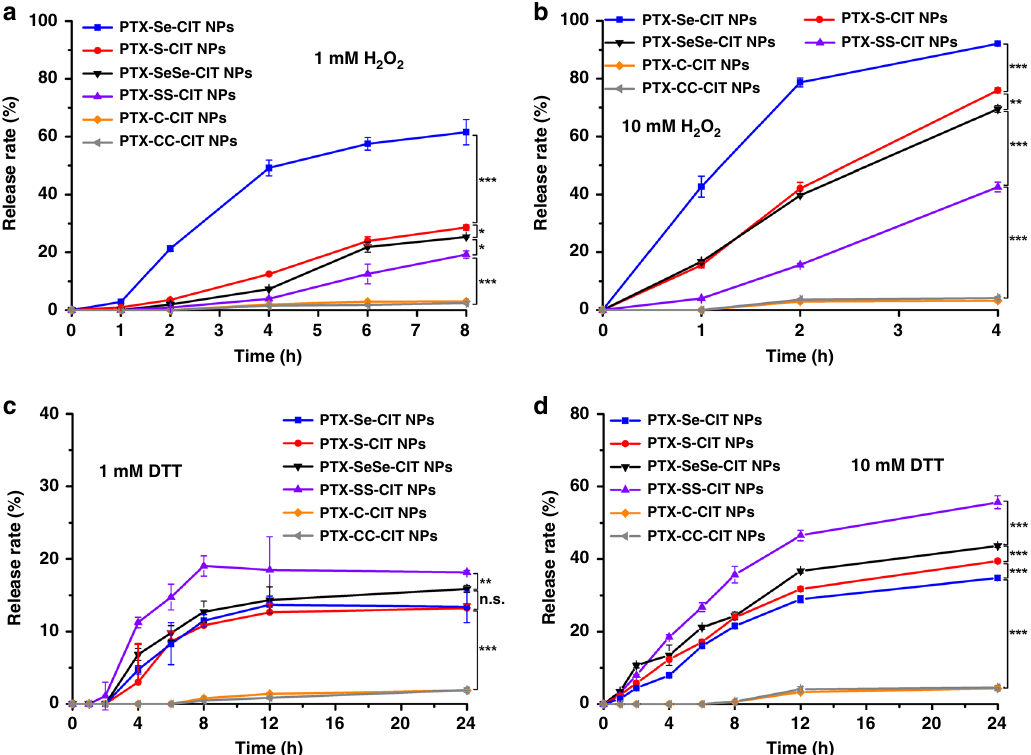
Fig. 2 In vitro redox-responsive drug release. ( a ) 1 mM H 2 O 2 ; ( b ) 10 mM H 2 O 2 ; ( c ) 1 mM DTT; ( d ) 10 mM DTT. Data are presented as mean ± SD (three independent experiments). * P < 0.05, ** P < 0.01, *** P < 0.001 by two-tailed Student ’ s t Figure 19, DSPE-PEG 2K has good biocompatibility with KB cells.